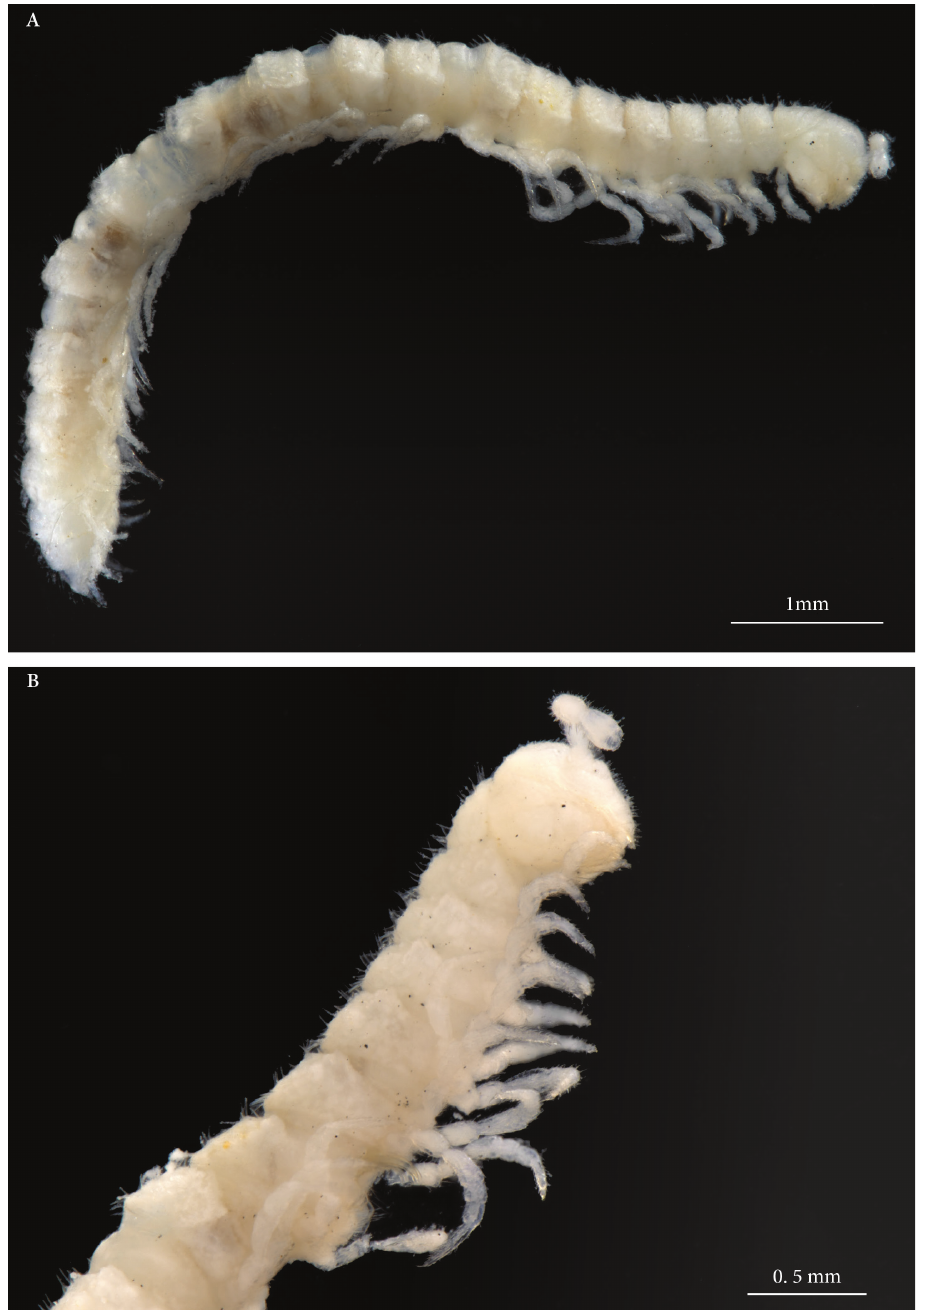
Figure 1. Haplocookia enghoffi sp. n. ♂ paratype NHMW 9366: A Habitus, lateral view B Head and first body rings, lateral